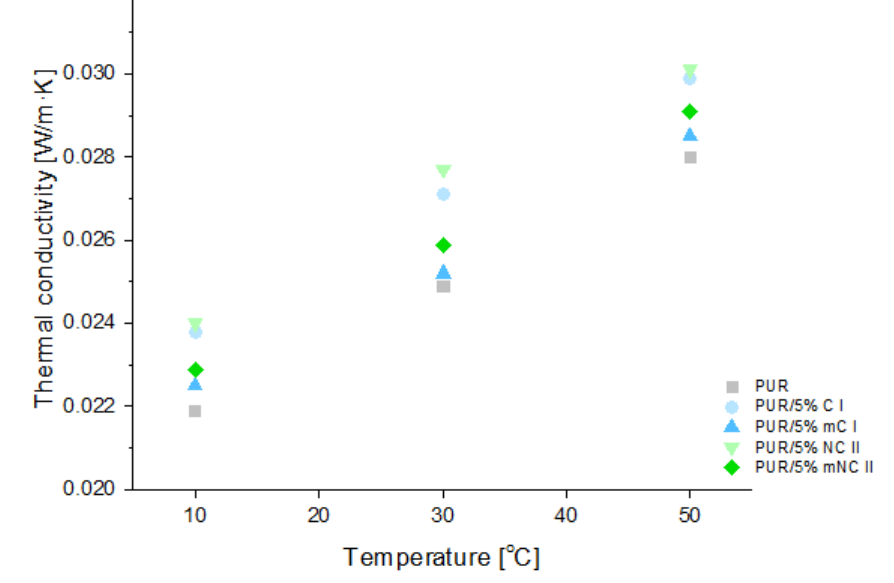
Figure 9. Thermal conductivity of composites depending on filler type (5% loading).